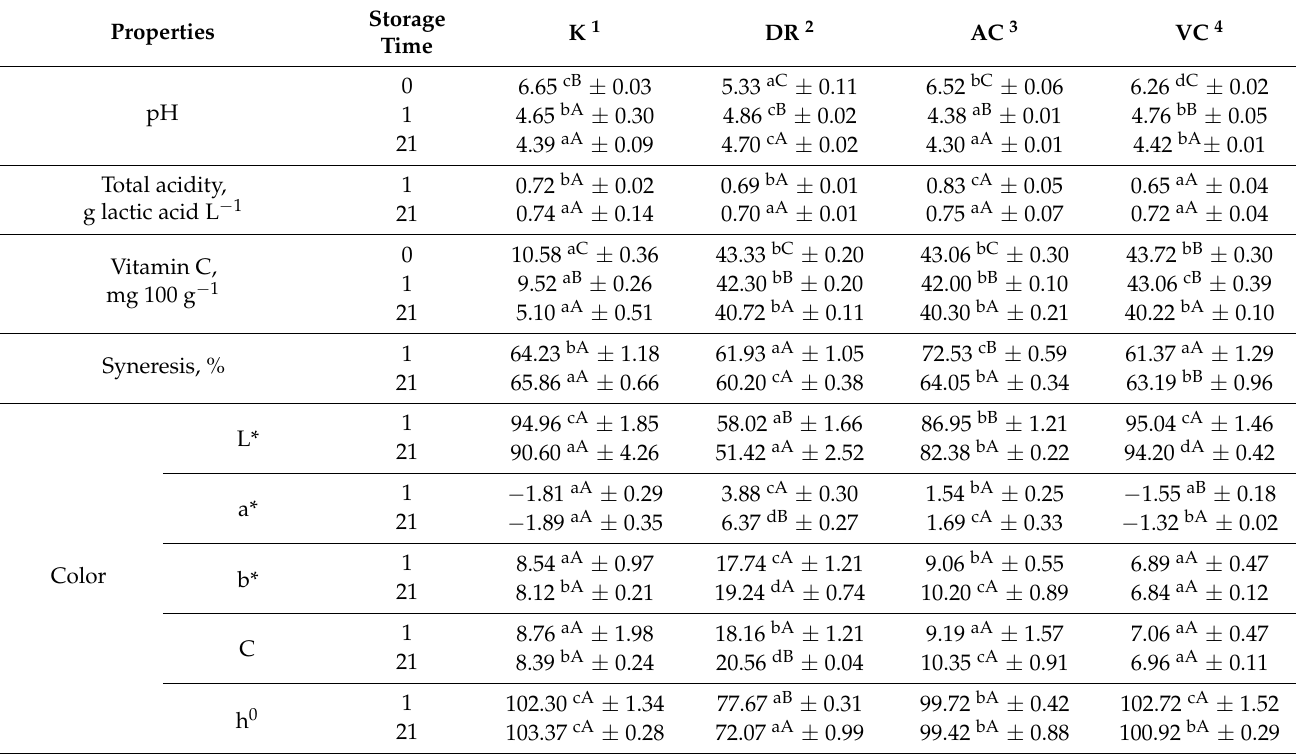
Table 1. Vitamin C, color, syneresis, pH and total acidity of fermented